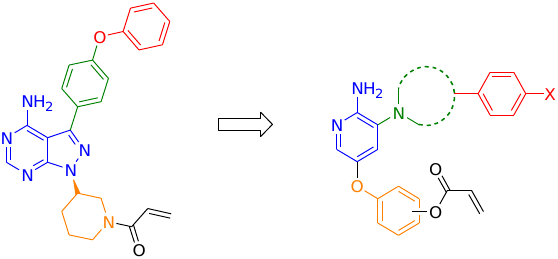
Figure 2. Design strategy for a novel series of aminopyridine derivatives as inhibitors of BTK. Red, lipophilic aryl substituent; green, lipophilic group linker; blue, hinge binder; orange, Michael acceptor linker.